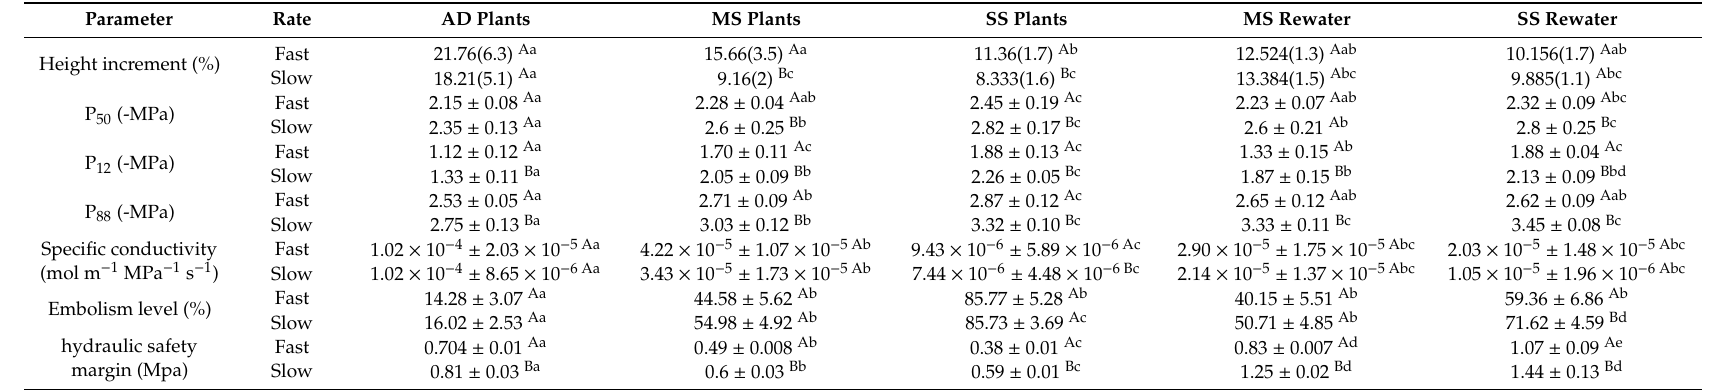
Table 1. Traits related to biomass production and hydraulics in two poplar genotypes (I-101 ( Populus alba L.) × 84K ( Populus alba L. × Populus glandulosa Uyeki)) under three water regimes (including AD (control, absence of drought), MS (moderately water-stressed) and SS (severely water-stressed) at the end of drought (including rewater). Di ff erent letters (the same treatment but di ff erent rates in the upper case; the same genotype but di ff erent treatments in the lower case) indicate significant di ff erences in the means ( p < 0.05, means ±